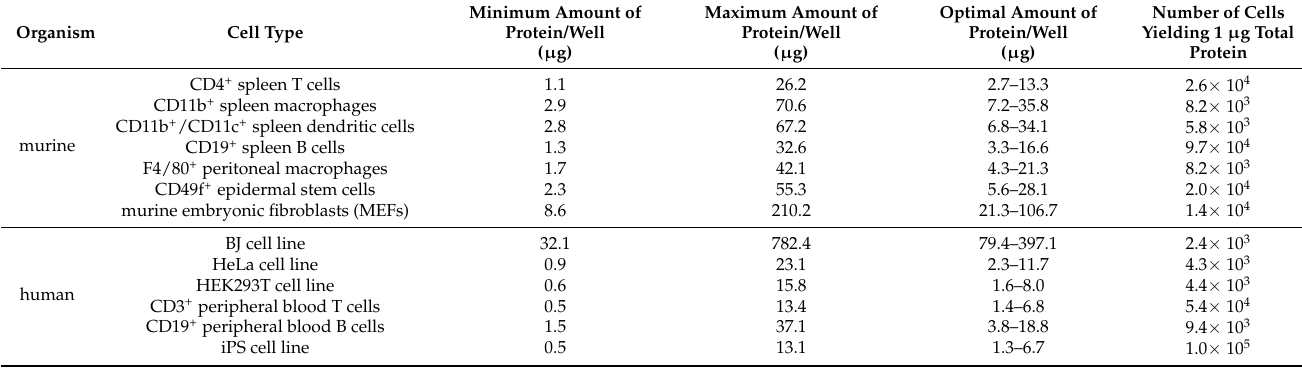
Table A1. RNaseH2 assay working range for different cell types. Columns show minimum, maximum and recommended amount of total protein for each cell type to achieve minimum (4.5 eqU), maximum (200 eqU) or optimal (>20 eqU, <100 eqU) substrate conversion rates. The approximate number of cells needed for a yield of 1 µ g of total protein is shown on the